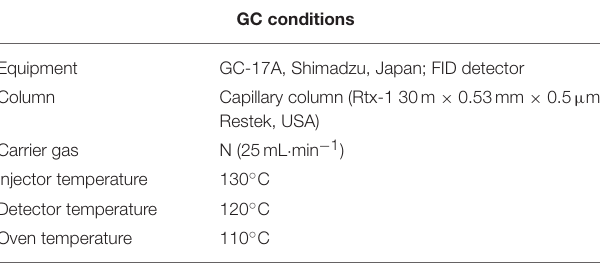
TABLE 1 | GC conditions for ethylene production.